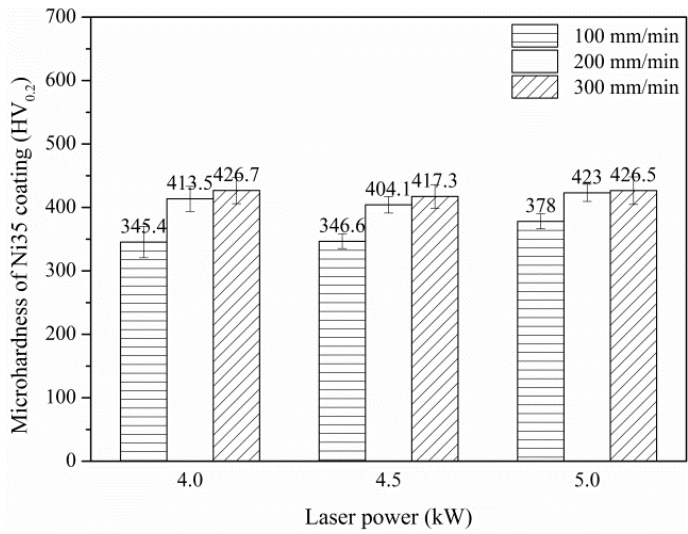
Figure 11. Average microhardness of Ni35 coatings.